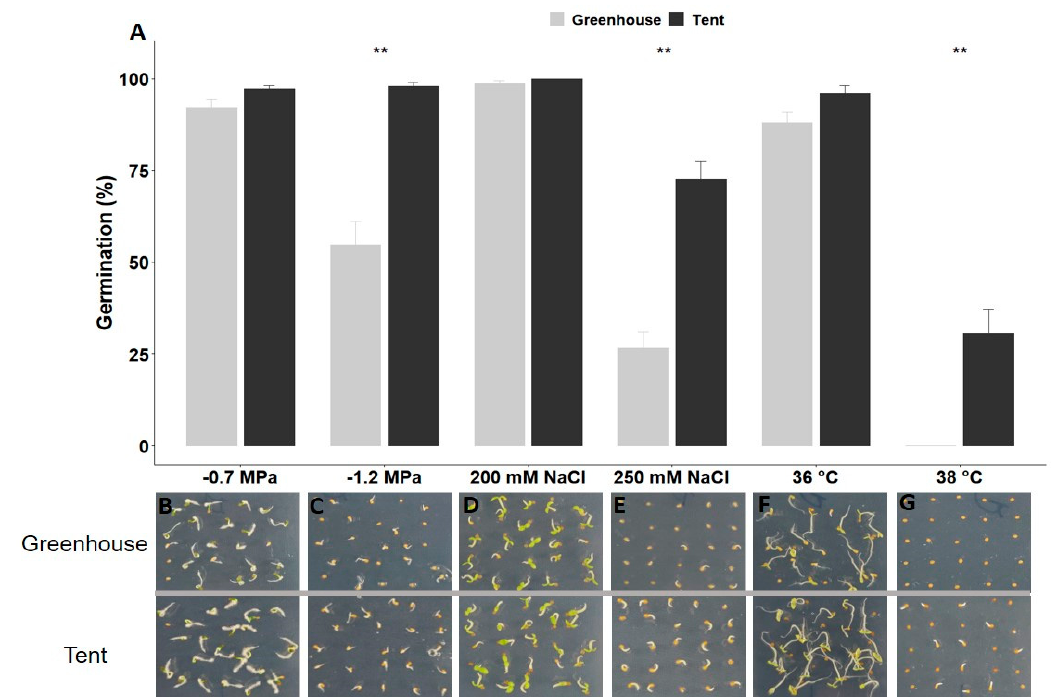
Figure 3. Germination response of petunia seeds from greenhouse or tent plants to dehydration, salinity, and high-temperature treatment. ( A ) Germination percentage of seeds from greenhouse or tent plants under polyethylene glycol (PEG), NaCl, and high-temperature treatment. ( B – G ) Representative images of seed germination on a 1% agar plate infused with PEG8000 ( B , C ), with NaCl ( D , E ), or at different high temperatures ( F , G ). The percentage of germination was recorded after a 7-day imbibition. Six replications, with 25 seeds for each replication ( n = 150 total), from greenhouse or tent plants were applied to each treatment. The vertical bars represent the mean ± standard error. ** Significant difference between seeds from greenhouse and tent plants under the same germination condition at p < 0.01 ( t -test).